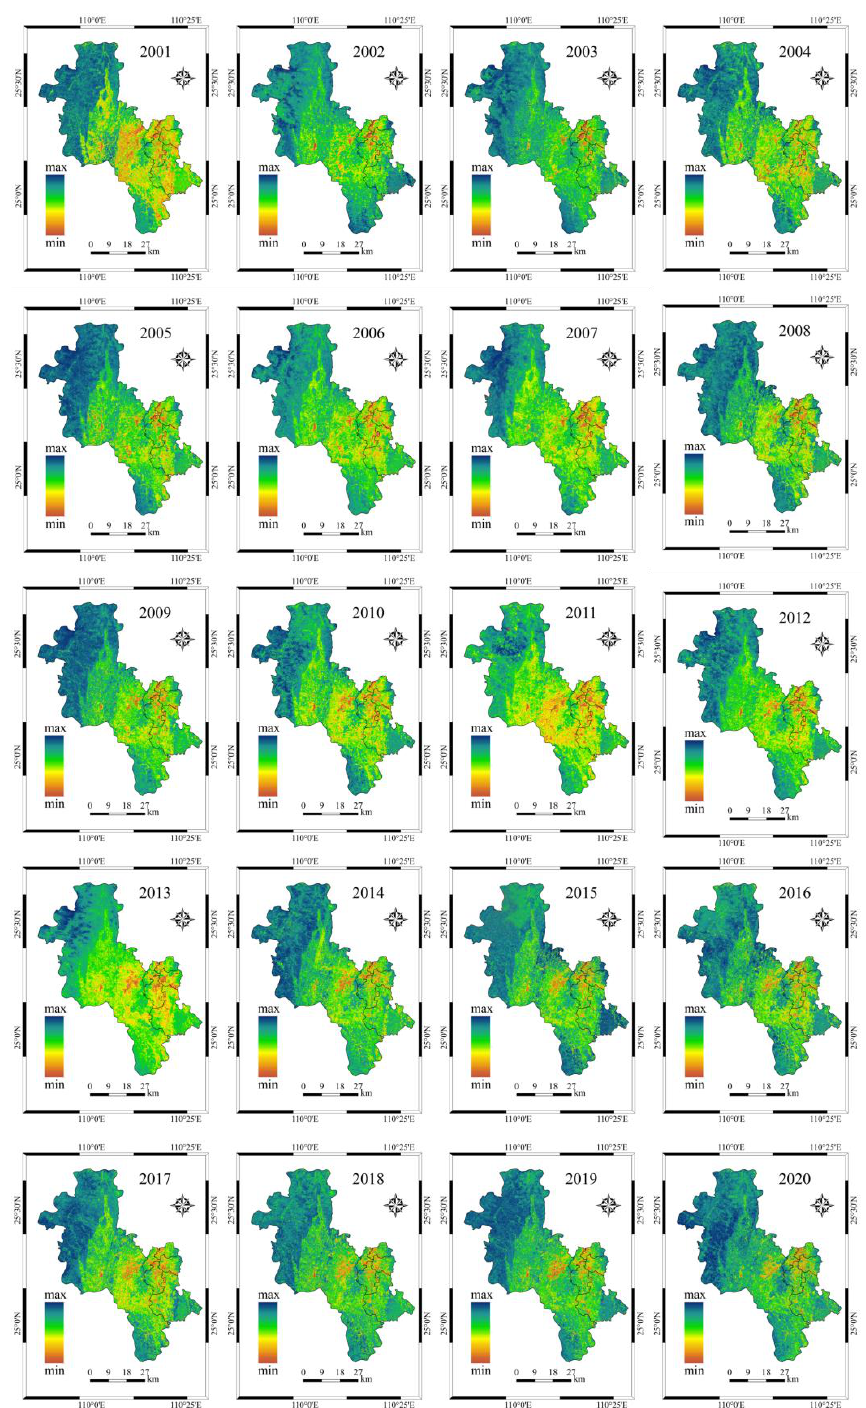
Figure 9. Annual spatial and temporal distribution of CCDM.